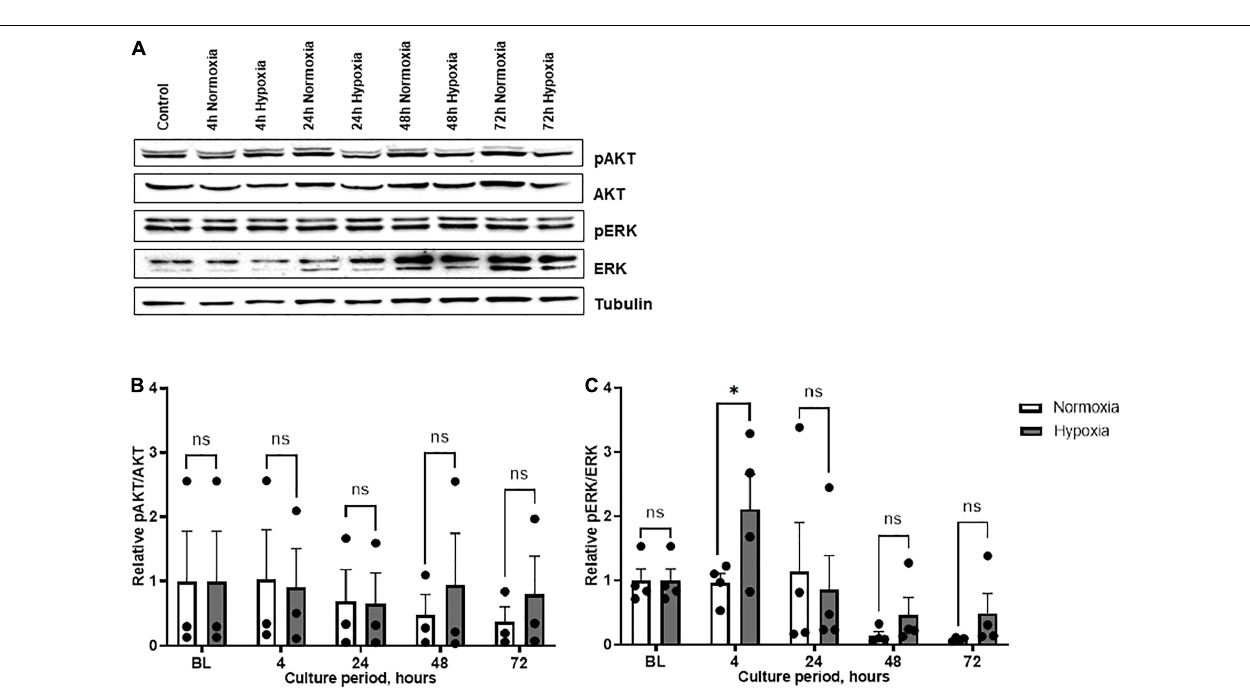
FIGURE 5 | AKT and ERK phosphorylation in ASCs under normoxia and hypoxia in patient group B. Group B included adipose tissue samples from chronic non-healing wounds, which exhibited high MIF secretion in the hypoxic culture of ASCs. Cells were cultured in growth medium at normoxic oxygen levels of 21% O 2 or hypoxic oxygen levels of < 1% O 2 . Cell lysates were obtained at indicated measuring points and Western blot analysis was performed and evaluated using the AIDA software. Tubulin was detected for total protein standardization. (A) Blots are representative of all Western blots performed to detect levels of phosphorylated AKT (pAKT), AKT, phosphorylated ERK (pERK), and ERK. Analyses were performed for three biological replicates ( n = 3). The graphs display (B) relative pAKT/AKT and (C) relative pERK/ERK were normalized to the baseline value at 0 h, set to one. Data are mean values ± SEM (two-way ANOVA, Holm-Šídák’s multiple comparisons test, ∗ p <